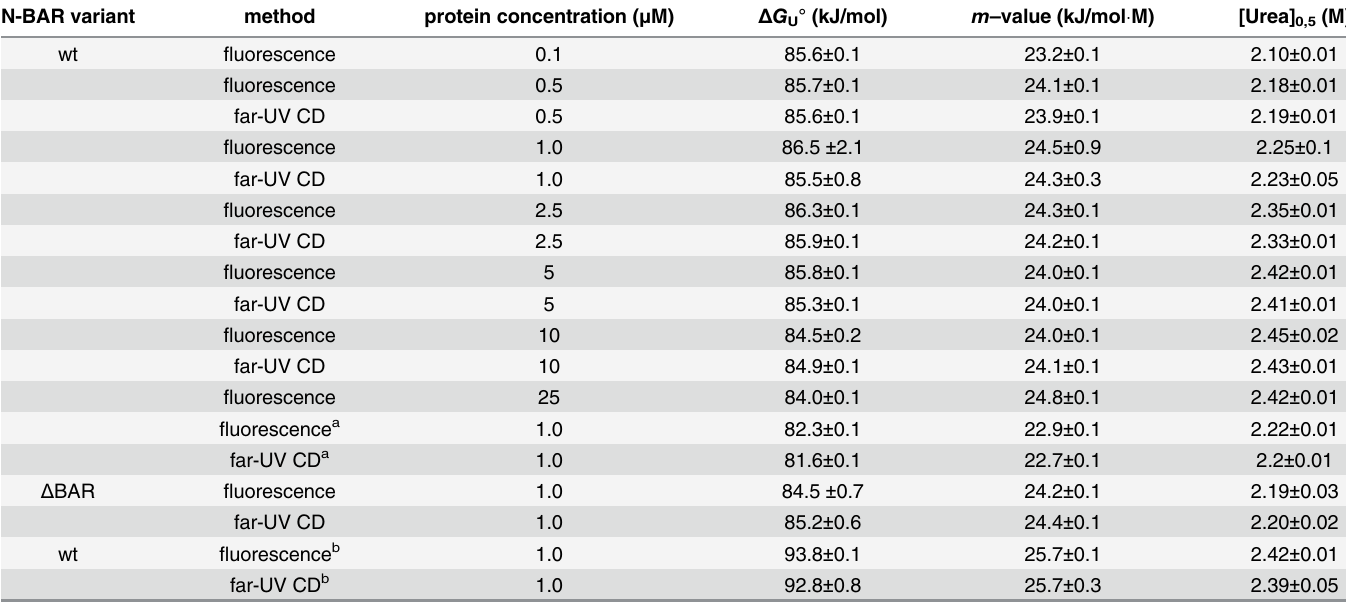
Table 1. Thermodynamic analysis of urea induced equilibrium unfolding of